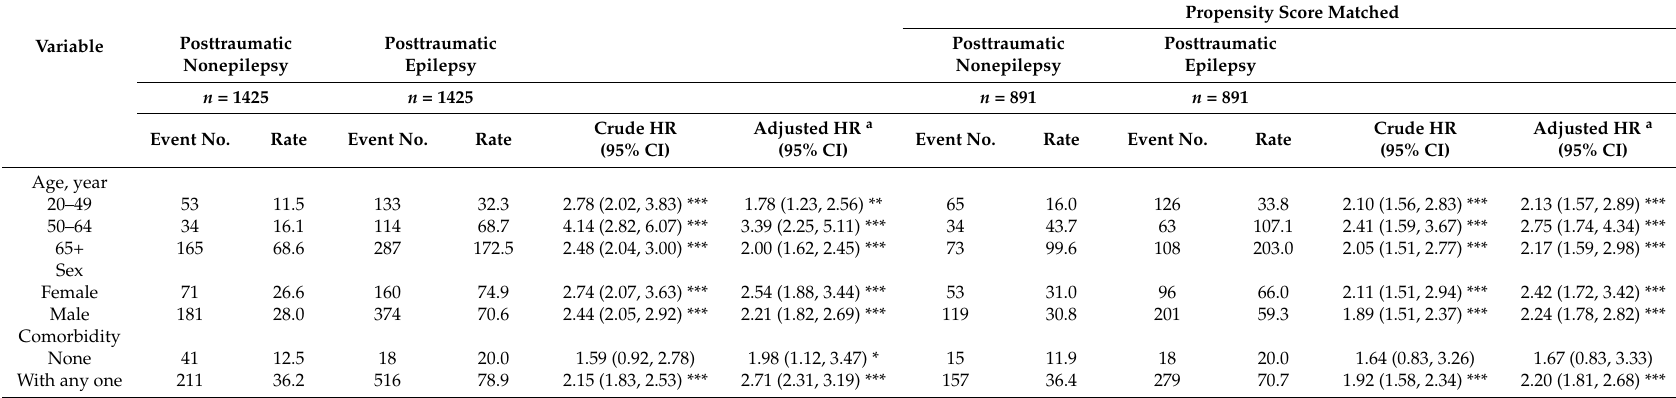
Propensity Score Matched Posttraumatic Posttraumatic Nonepilepsy Epilepsy